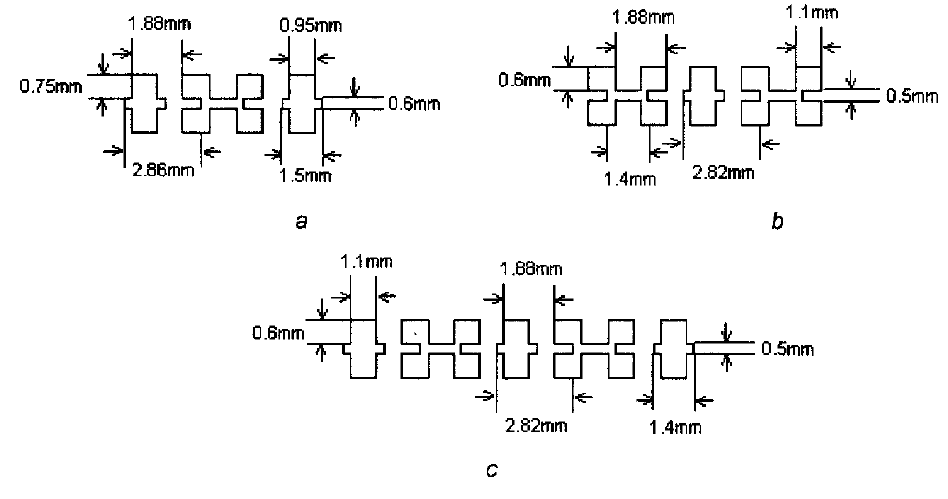
FIGURE 2 Patterns of the three proposed